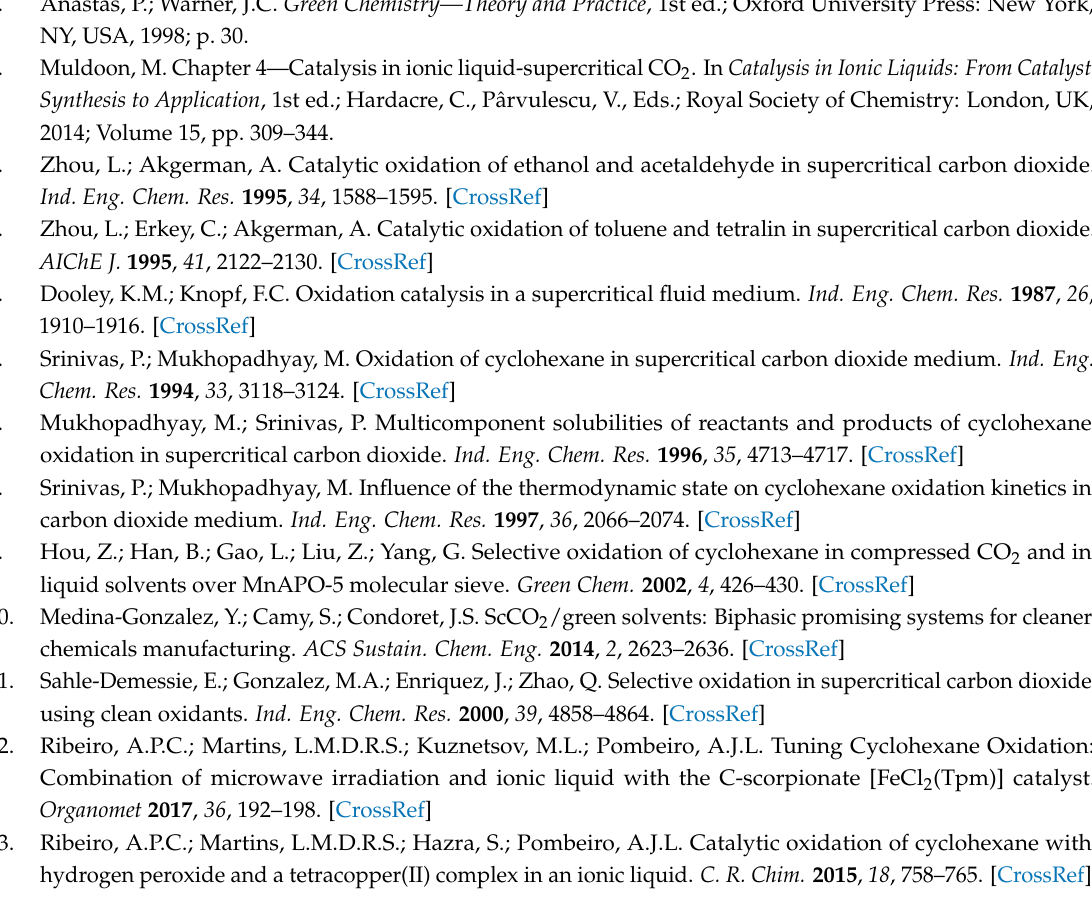
Table S1: Selected data for the cyclohexane oxidation using FeCl 2 · 2H 2 O as catalyst. Acknowledgments: Financial support from the Fundaç ã o para a Ci ê ncia e a Tecnologia (FCT), Portugal, for fellowship SFRH/BPD/90883/2012 to A.P.C.R. and for the UID/QUI/00100/2013,